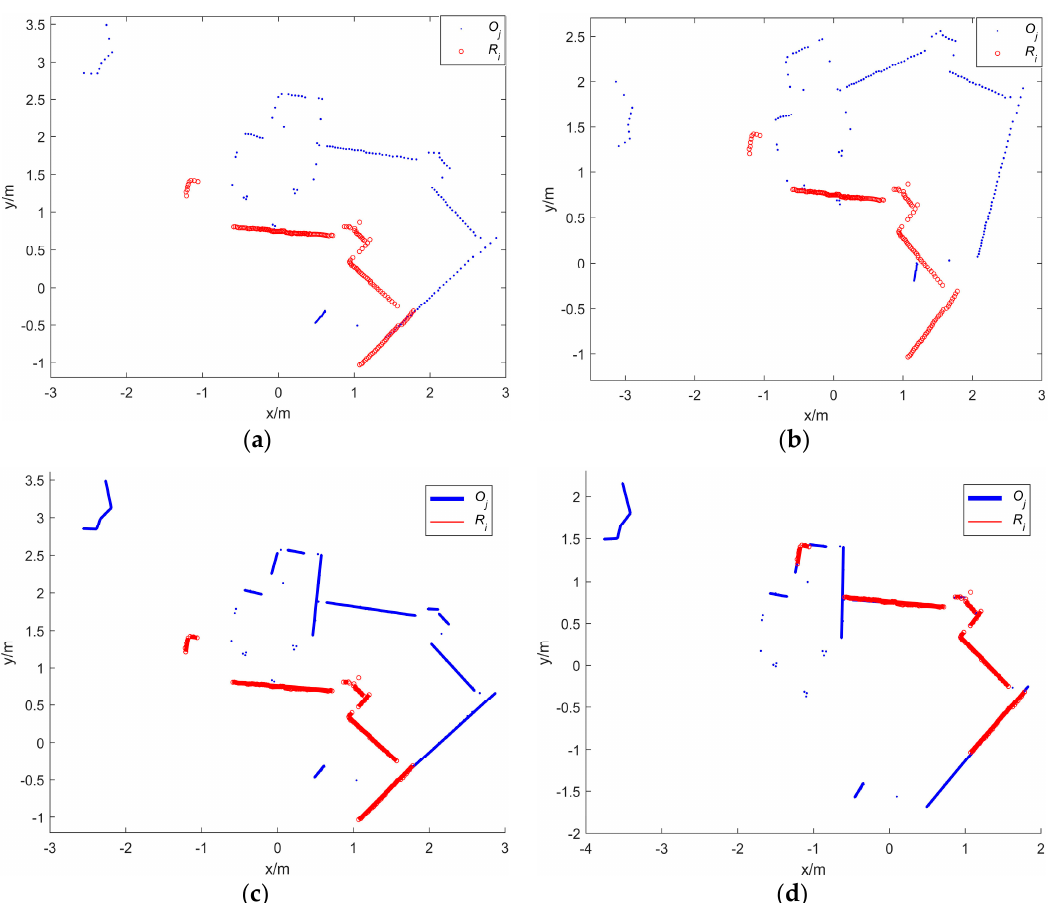
Figure 16. ICP and lidar data registration of this algorithm: ( a ) two frames of laser point cloud; ( b ) registration result of ICP algorithm; ( c ) line segment features of two frames of laser point cloud; ( d ) registration result of the algorithm in this paper.